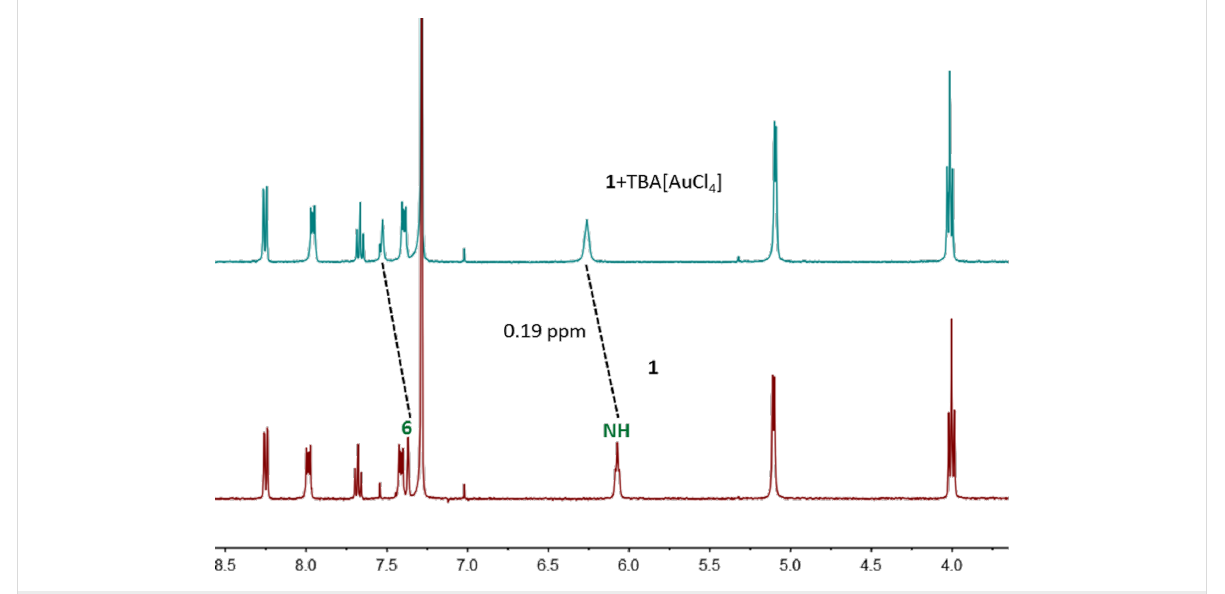
Figure 3: Partial 1 H NMR spectra (500 MHz, CDCl 3 , 0.5 mM, 298 K) of 1 and the equimolar mixture with TBA[AuCl 4 ].